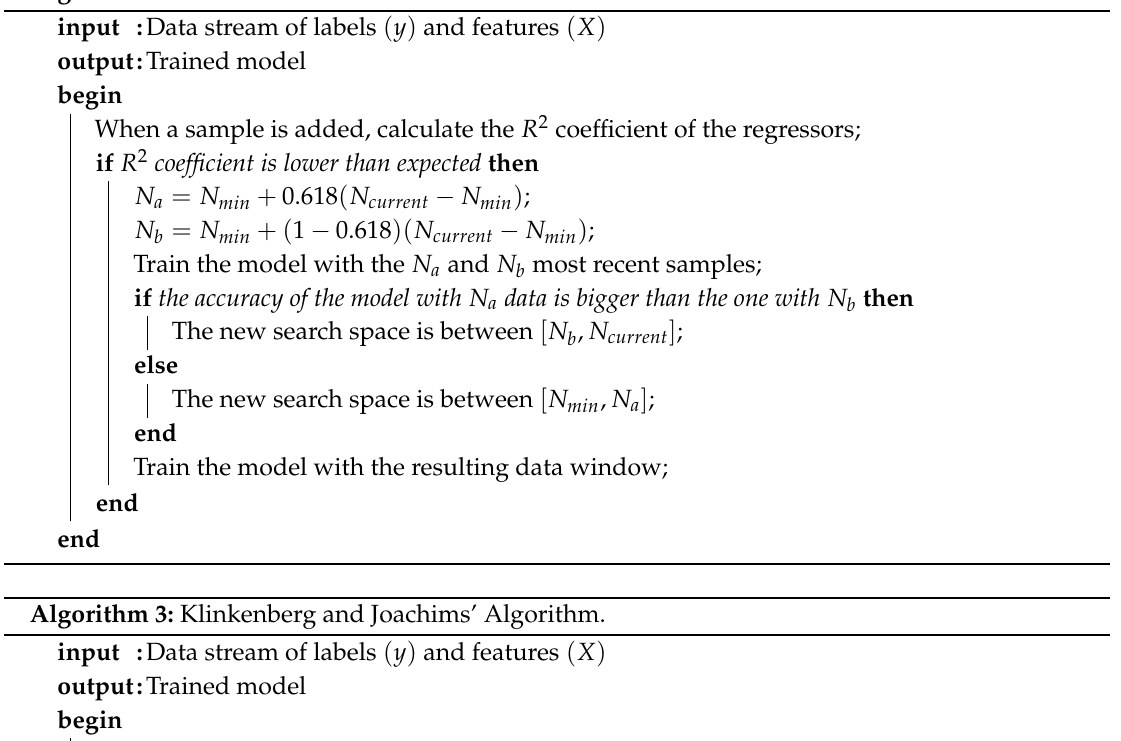
Algorithm 2: Gold ratio method.